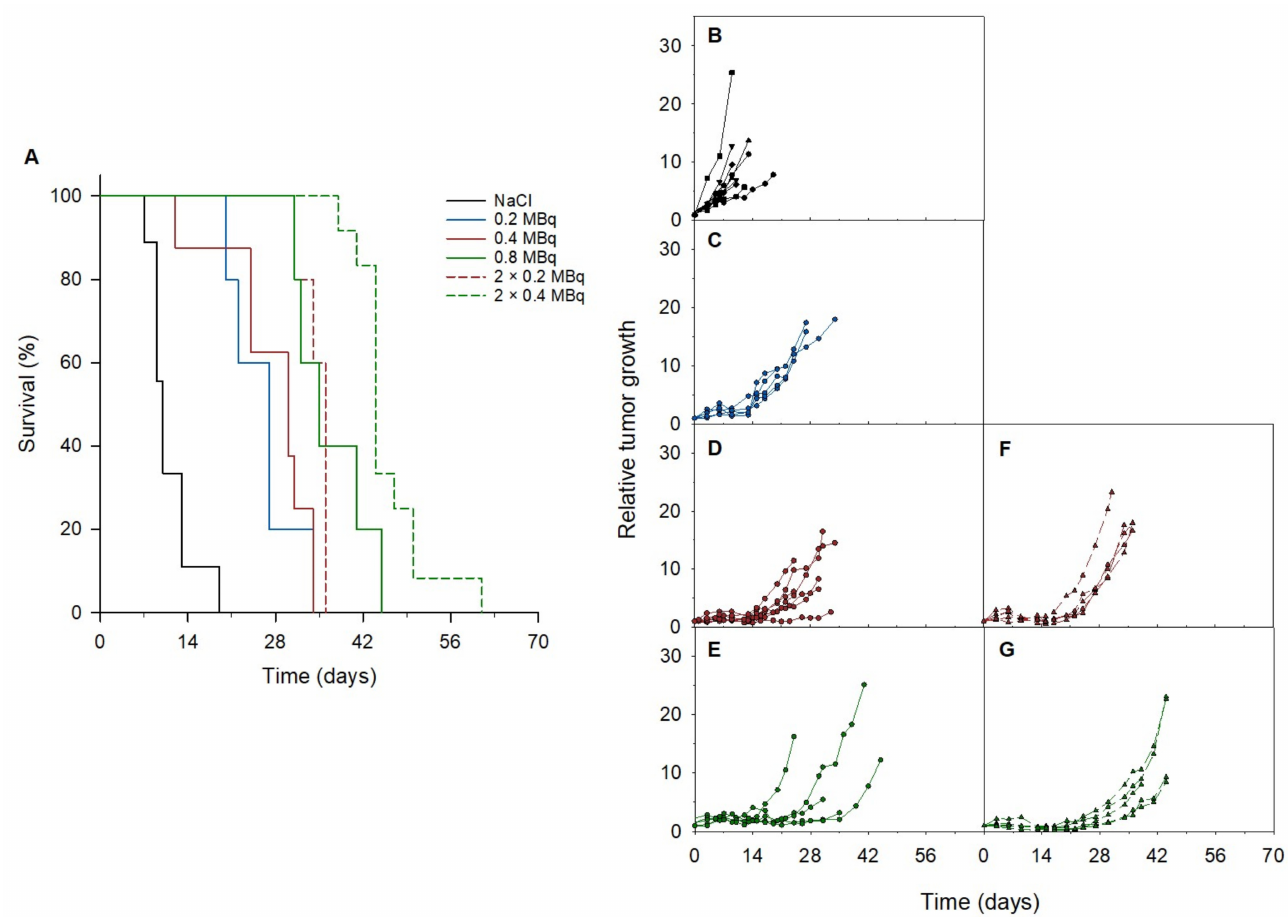
Figure 4. ( A ) Survival and ( B – G ) relative tumor growth of PC-3 PIP xenografts treated with ( B ) saline ( n = 9), ( C ) 0.2 ( n = 5), ( D ) 0.4 ( n = 8), ( E ) 0.8 ( n = 5), ( F ) 2 × 0.2 ( n = 5) or ( G ) 2 × 0.4 ( n = 12) MBq